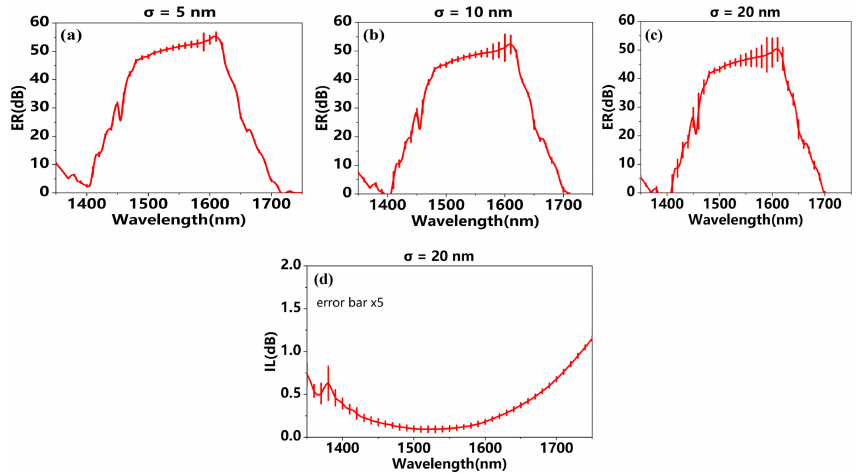
Figure 10. Extinction ratio obtained under the grating ridge jitter variance of ( a ) σ = 5 nm; ( b ) σ = 10 nm; and ( c ) σ = 20 nm. ( d ) Insertion loss obtained under the grating ridge jitter σ = 20